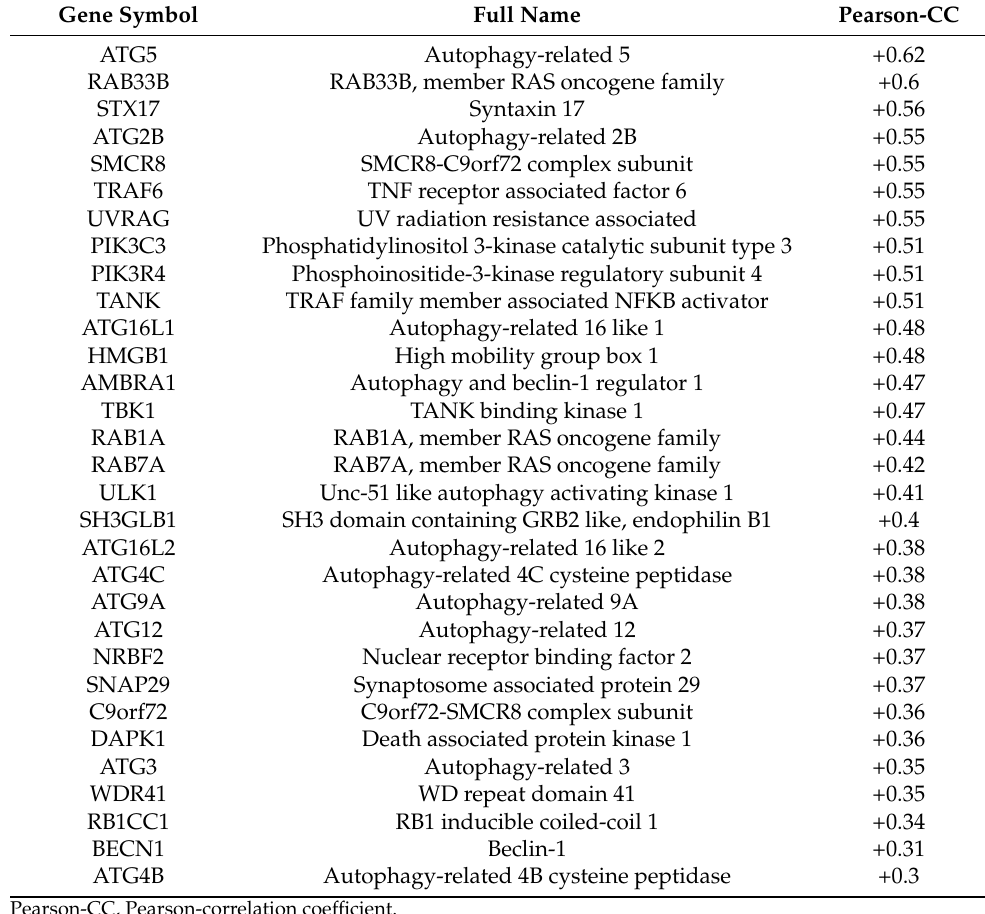
Table 1. Autophagy-related genes positively and significantly correlated with FOXO3 in human HCC